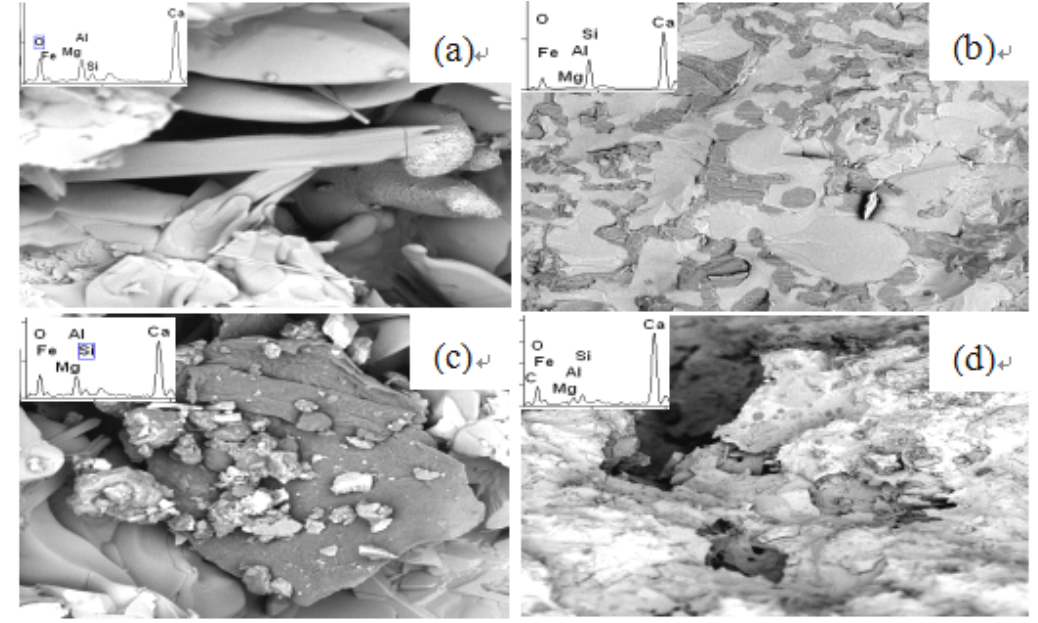
Figure 9: SEM images of reconstructed steel slag with different CaSO 4 contents. (a) 1, (b) 2, (c) 3, and (d) 4 wt% CaSO 4